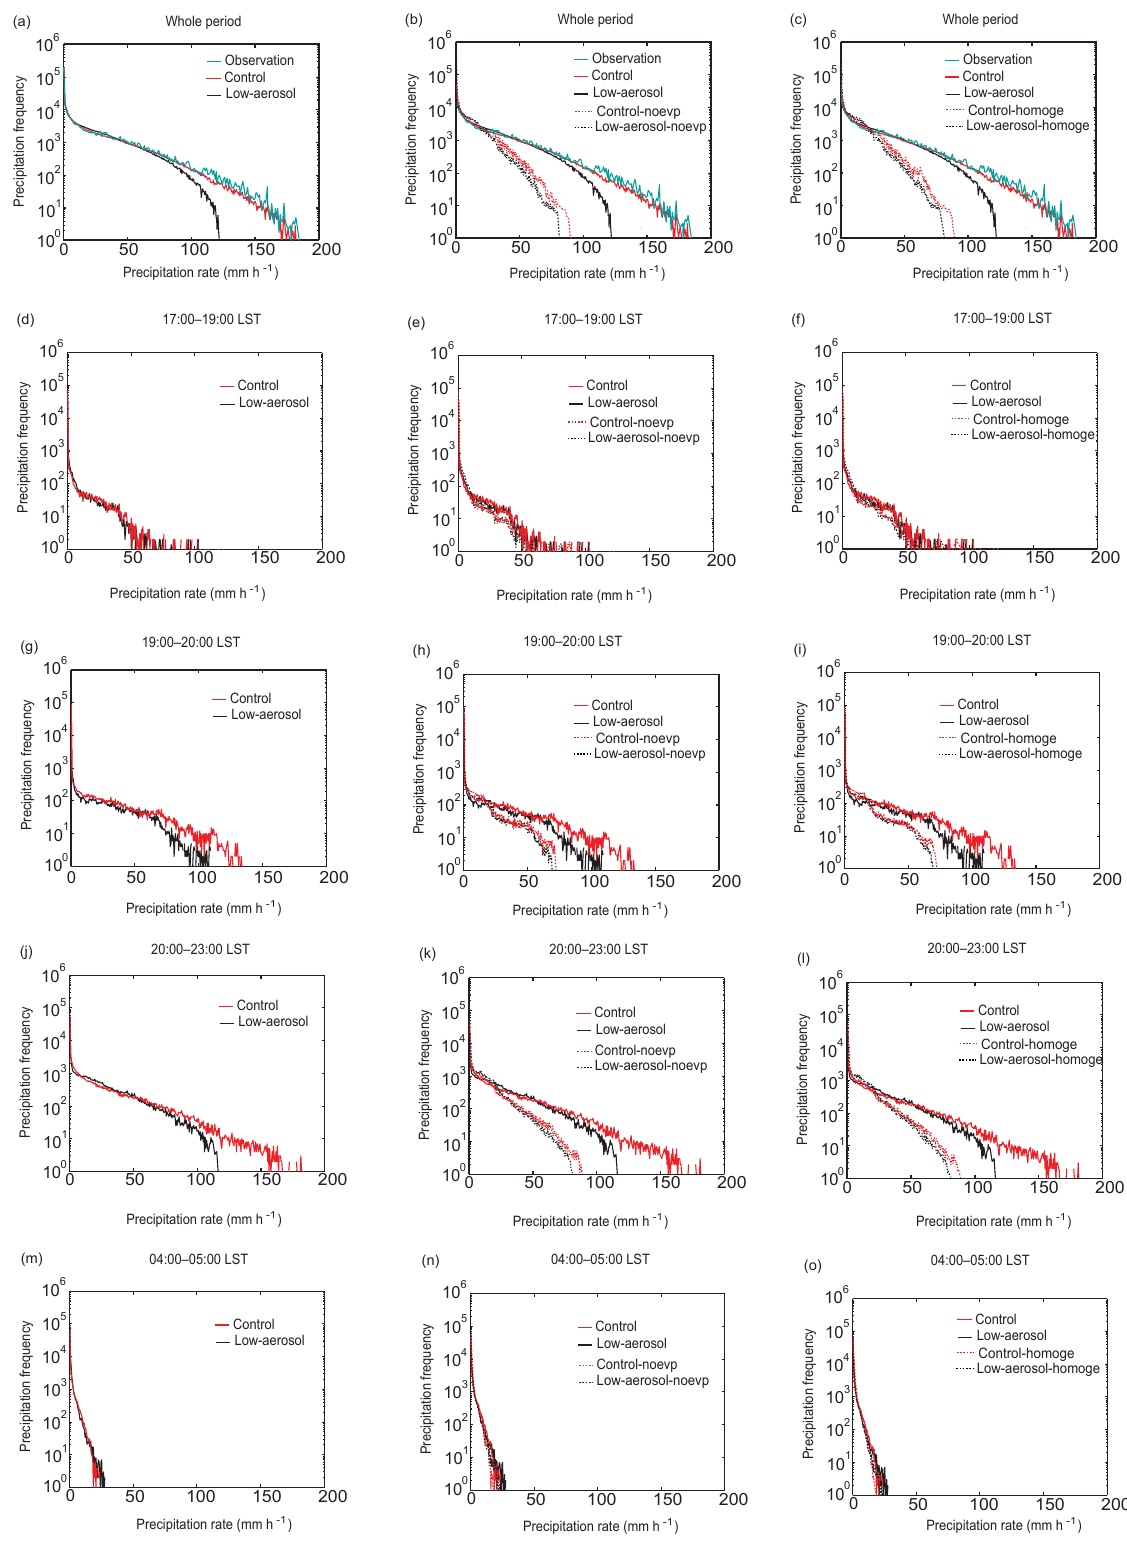
Figure 7. Frequency distributions of the precipitation rates at the surface, which are collected over the whole domain, for (a, b, c) the whole simulation period, (d, e, f) a period between 17:00 and 19:00LST, (g, h, i) a period between 19:00 and 20:00LST, (j, k, l) a period between 20:00 and 23:00LST, and (m, n, o) a period between 04:00 and 05:00LST. In panels (a) , (b) , and (c) observed frequency, which is interpolated to the simulation time steps and grid points, is also